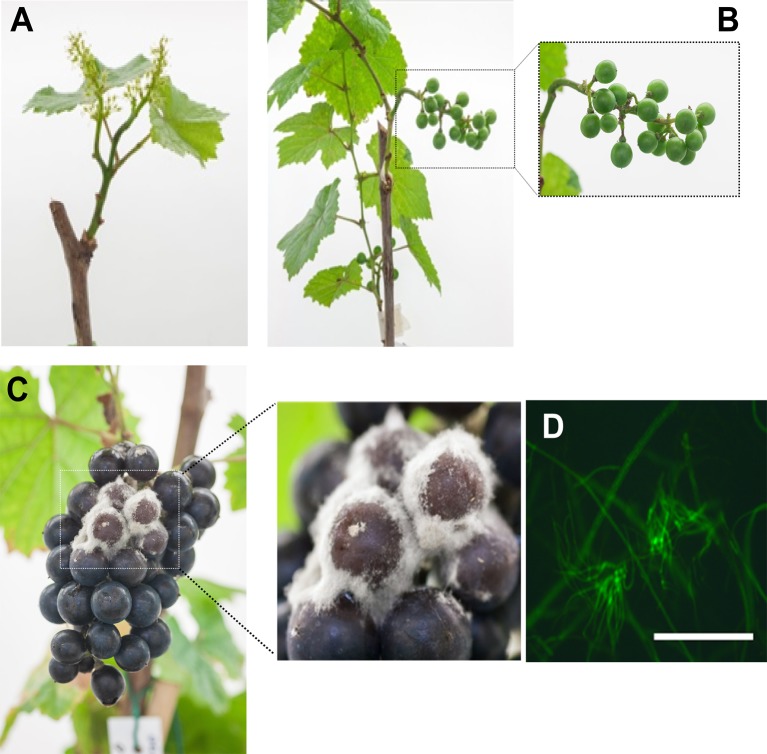

Botrytis cinerea infected grapevine flowers and their development until berry ripening. (A) Flowers 24 hours post inoculation with GFP-labelled B05.10 strain at full cap-fall stage (EL25/26). (B) Healthy looking, asymptomatic, hard-green berries at 4 weeks post inoculation (wpi). (C) Egression of B. cinerea at ripening (12 wpi). (D) Fluorescence of mass of mycelia isolated from the outgrown B. cinerea; white bar represents 50 µm.